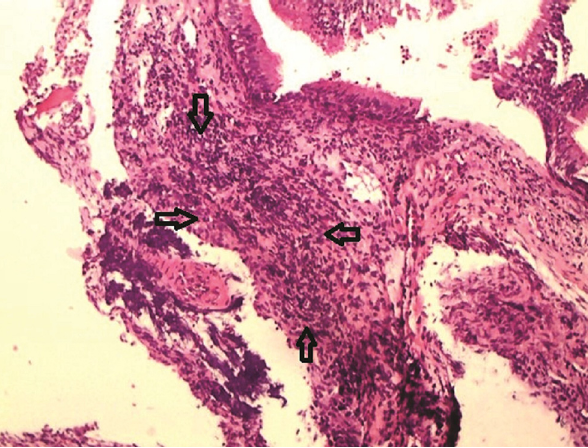
Figure 2 Sinus mucosa on the right side of the study group euthanized after 10 days, with moderate inflammation char- acterized by diffuse inflammatory infiltrate in the lamina propria, without formation of inflammatory aggregates (grade 2), delimited by arrows --- optical microscope, HE staining, 100 × magnification.